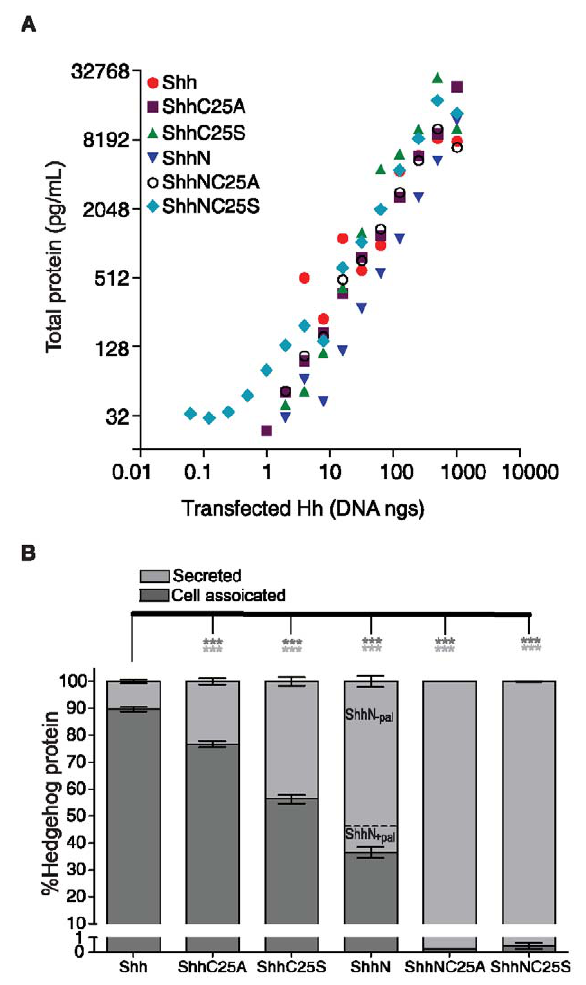
Figure 2. Shh lipid modifications enhance cellular association. (A) Each of the constructs conferred dose dependent and similar expression levels of recombinant Shh protein. Shown are the sums of protein measurements in cell lysate and culture medium from NIH3T3 cells transfected with a range of cDNA for Shh, ShhC25S, ShhN, and ShhNC25S. (B) Precise quantification of recombinant Shh protein concentrations in either the cell lysate or culture medium revealed both cholesterol and palmitate modifications confer cellular association. Shown are the averages of Shh protein measurements from cells transfected with cDNA (62.5 ng to 500 ng in two fold increments). With both lipid adducts, 89.7% of Shh was recovered in the lysate and 10.3% was secreted in the culture medium. Less protein was measured in lysates from cells expressing Shh without a palmitate adduct, (76% for ShhC25A and 56.3% for ShhC25S). Examination of the culture medium from cells transfected with ShhN by HPLC (Figure S1) revealed the presence of two species of protein, one that was palmitoylated (ShhN + pal ) and one that was not (ShhN 2 pal ). Approximately 13% of secreted ShhN was palmitoylated (ShhN + pal ). The portion of cell- associated ShhN (36.5%) represents the ShhN + pal species because in the absence of either lipid moiety, less than 0.5% of ShhNC25A and ShhNC25S protein was recovered from cell lysate. Protein measure- ments were performed in replicates of four ( 6 s.e.m.) *** p , 0.001 compared to Shh-transfected cells.